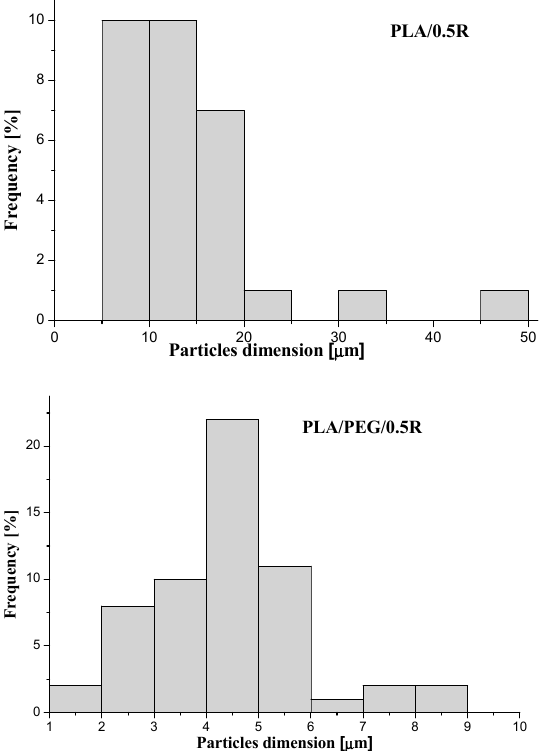
Figure 3. The distribution of particle dimensions determined from SEM images.